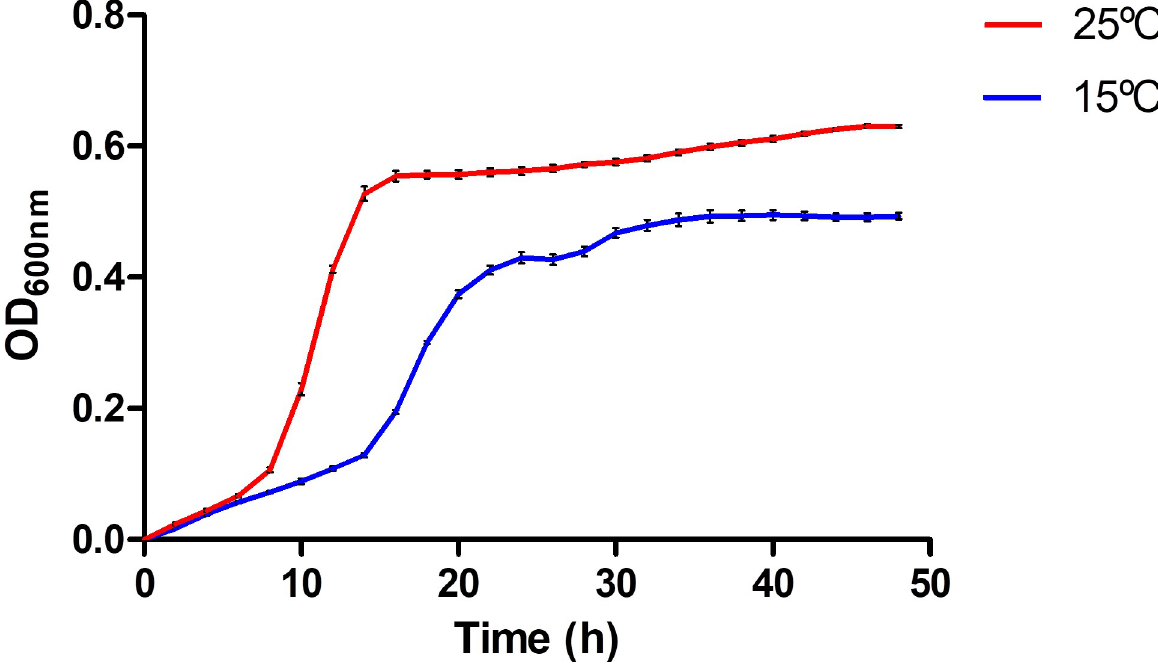
Fig 1. The influence of temperature cultivation in growth dynamics of Pdd . Growth of RM-71 strain was assayed at 15˚C and 25˚C in TSB-1 for 48 h. Vertical error bars represent standard deviation of biological triplicates.